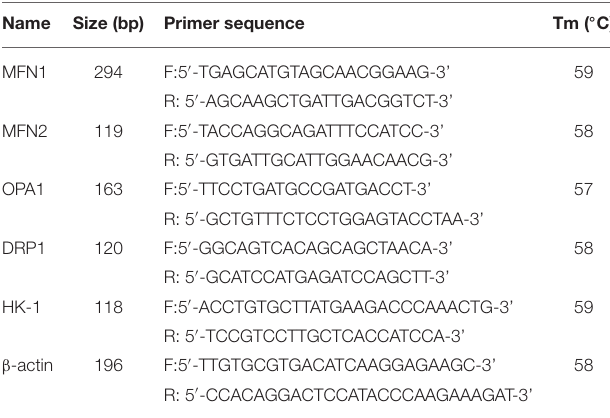
TABLE 1 | Primer sequences used to amplify target genes using by quantitative real-time polymerase chain reaction (qRT-PCR). Name Size (bp) Primer